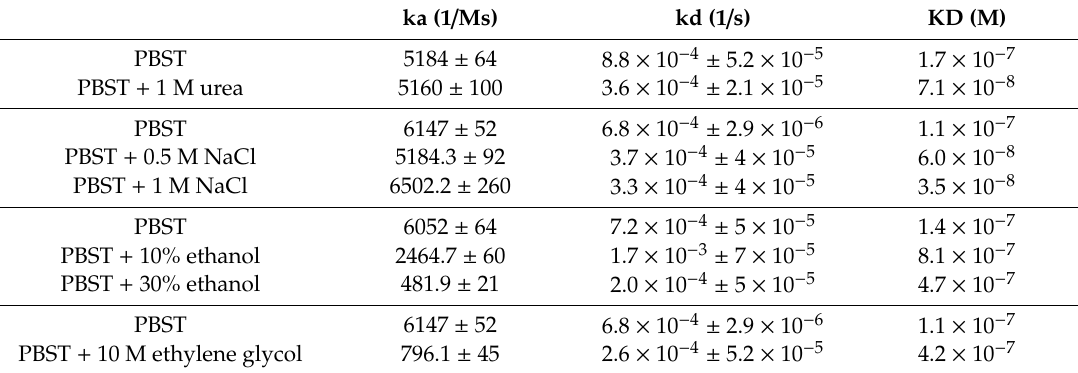
Table 2. Binding parameters (ka, kd, and KD) between EGCG and VEGF-165 under different physico-